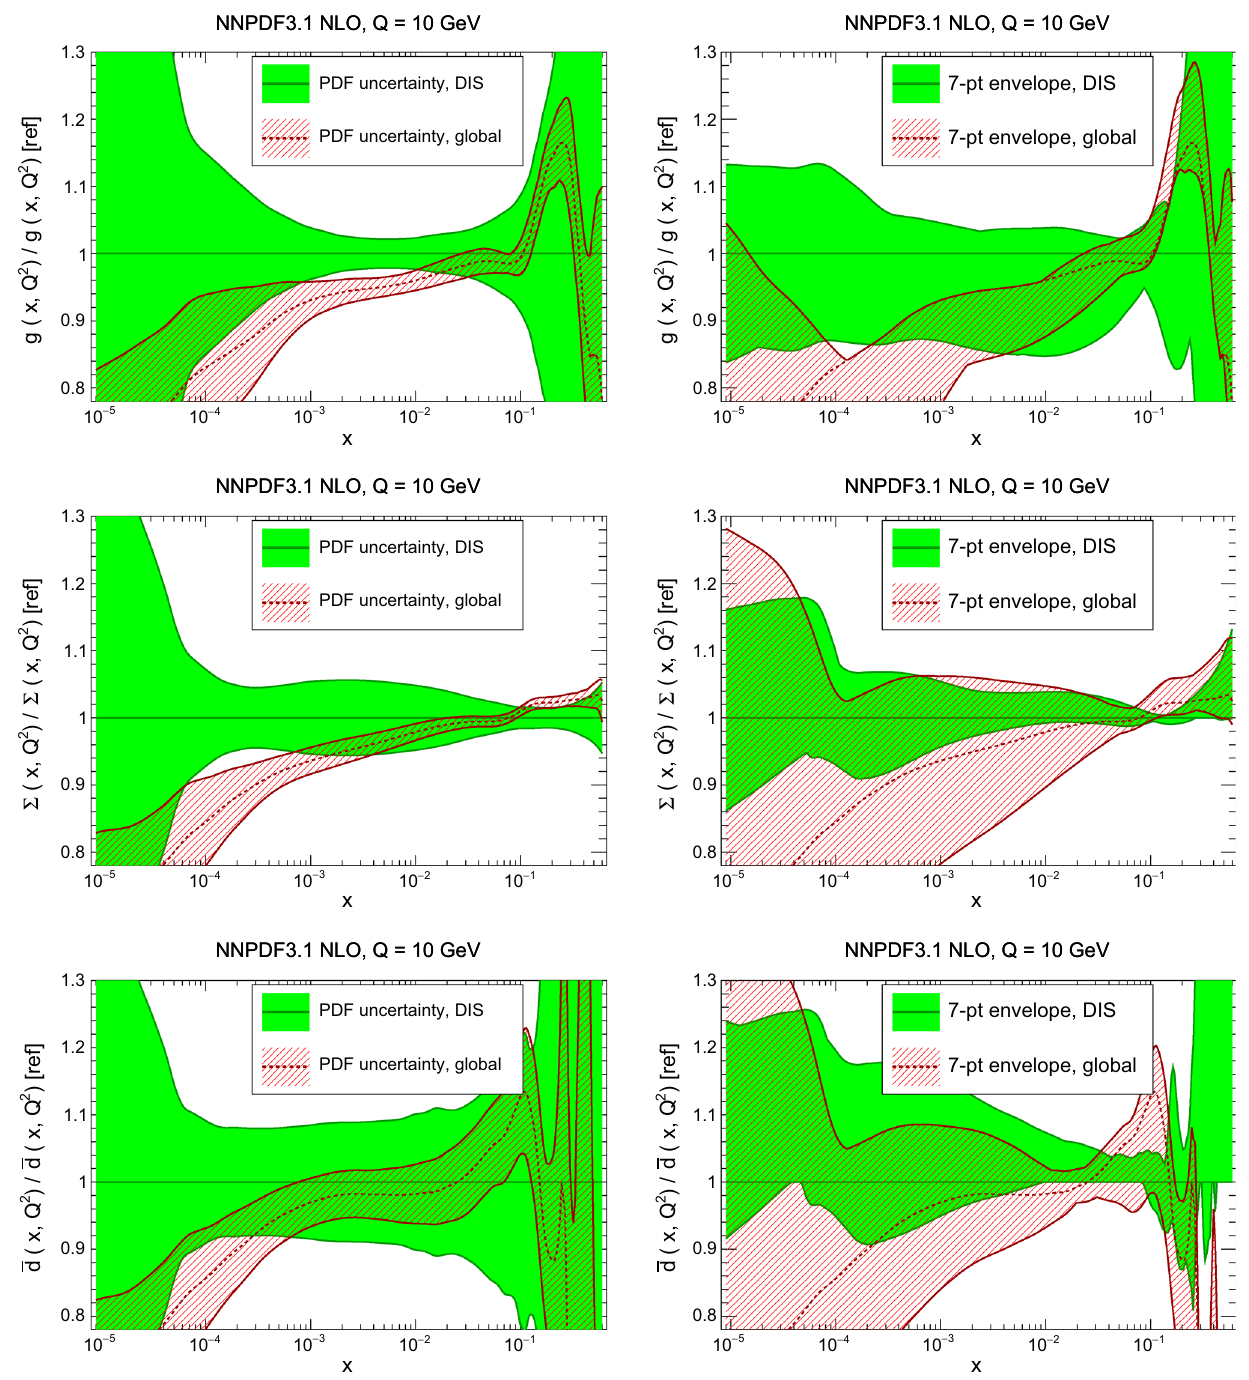
Fig. 26 Comparison between PDF uncertainties (left) and 7-point envelopes of scale variations (right) for the DIS and global PDFs. The gluon, quark singlet and antidown at Q = 10 GeV are